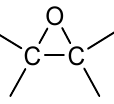
Figure 1. Epoxy functional group.